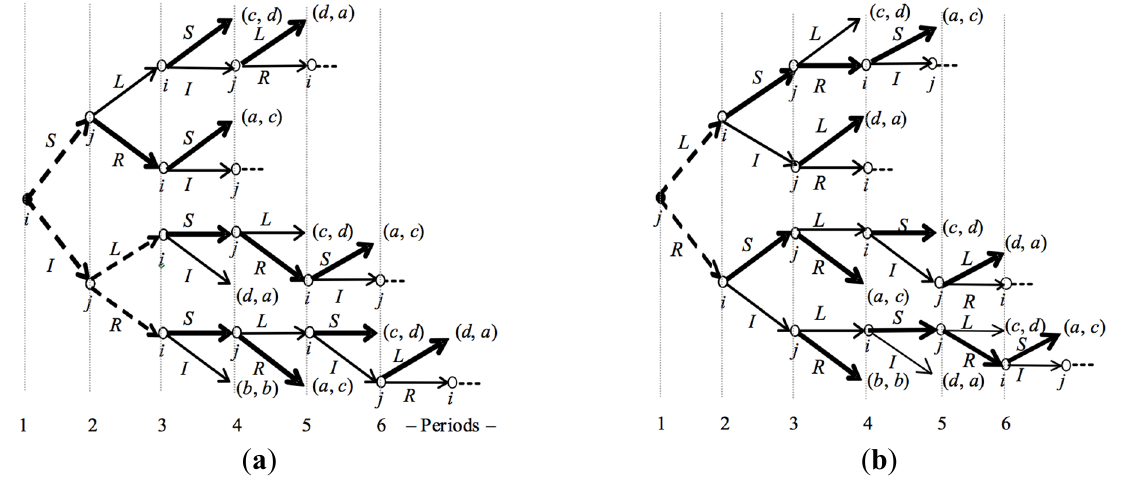
Figure 2. CP ( G ), G being the original game in Figure 1, with i ( a ) or j ( b ) as first